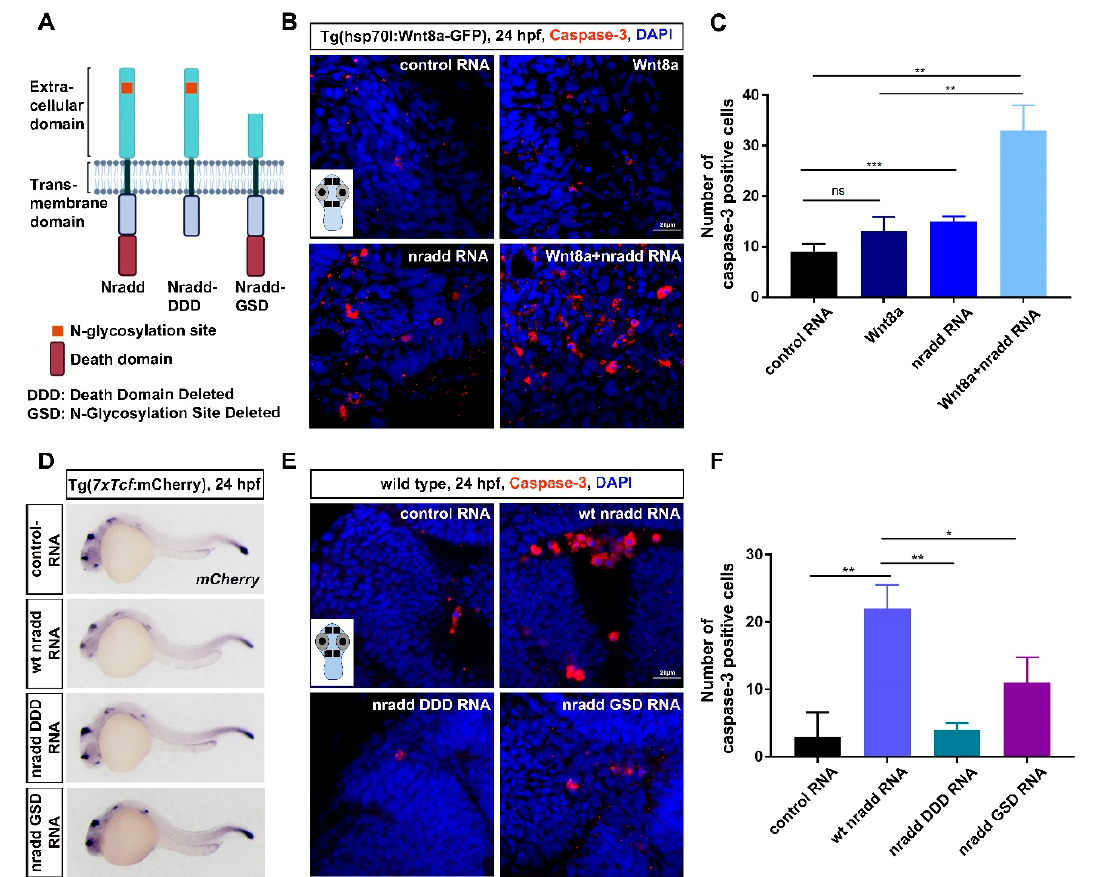
Figure 5. Nradd acts together with Wnt/ β -catenin signaling to promote apoptosis during development. ( A ) Schematic representation shows domain structures of wt Nradd, Nradd without the death domain (Nradd death domain deleted (DDD)) and Nradd without the N-glycosylated N-terminal region (Nradd glycosylation site deleted (GSD)). ( B ) Anti-cleaved caspase 3 staining of control, Wnt8a activated, nradd mRNA-injected and Wnt8a activated+ nradd mRNA-injected zebrafish embryos at 24 hpf. Sections are counterstained for DAPI. The inset shows a representative embryo with four different regions indicated with black rectangles that are used for counting the cleaved caspase 3-positive cells. The embryo image is created with BioRender.com. Scale bar: 20 µ m. nradd mRNA (250 pg) induces apoptosis in zebrafish embryos compared to control group and also acts together with Wnt8a to further enhance apoptosis. The experiment was performed in hs:Wnt8 transgenic embryos where Wnt8a expression is induced by giving a heat shock at 60% epiboly. Four independent experiments were conducted. ( C ) Quantification of cleaved caspase 3-positive apoptotic cells shown in (B). Numbers represent average number of apoptotic cells counted from four different regions of 20 embryos for each group. Error bars are SD, ** indicates p < 0.01 and *** indicates p < 0.001. ( D ) WMISH showing the loss of capacity in nradd DDD (250 pg) and nradd GSD (250 pg) mRNA to inhibit canonical Wnt signaling. mCherry WMISH shows downregulation of signaling in the transgenic 7xTcf:mCherry Wnt/ β -catenin reporter embryos by wt nradd (58/61). Overexpression of nradd DDD (44/46) or nradd GSD (51/52) cannot inhibit Wnt/ β -catenin signaling. Three independent experiments were conducted. ( E ) Anti-cleaved caspase 3 staining of control (100 pg), wt nradd (250 pg), nradd DDD (250 pg) and nradd GSD (250 pg) mRNA-injected zebrafish embryos at 24 hpf. Sections are counterstained for DAPI. The inset shows a representative embryo with four different regions indicated with black rectangles that are used for counting the cleaved caspase 3-positive cells. Scale bar: 20 µ m. nradd mRNA (250 pg) induces apoptosis in zebrafish embryos compared to control group, while nradd DDD or nradd GSD cannot. Three independent experiments were conducted. ( F ) Quantification of cleaved caspase 3-positive apoptotic cells shown in ( E ). Numbers represent average number of apoptotic cells counted from four different regions of 20 embryos for each group. Error bars are SD, * indicates p < 0.05 and ** indicates p <